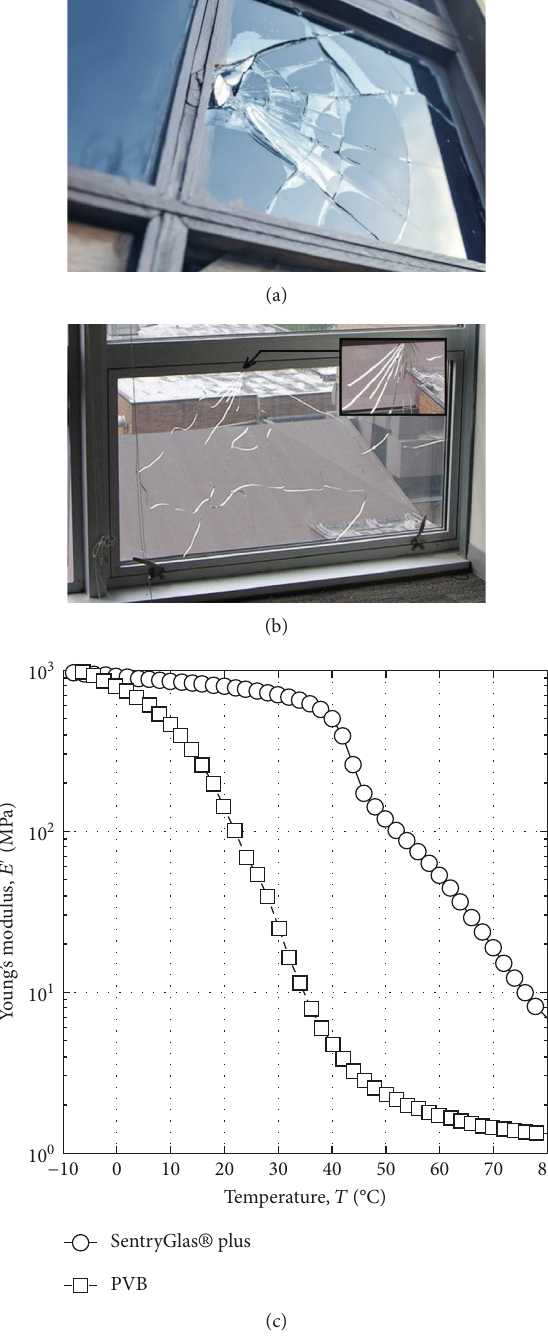
Figure 2: Laminated glass: (a)-(b) examples of fractured LG panels and (c) variation of shear modulus for common LG interlayers (PVB and SG degradation with temperature